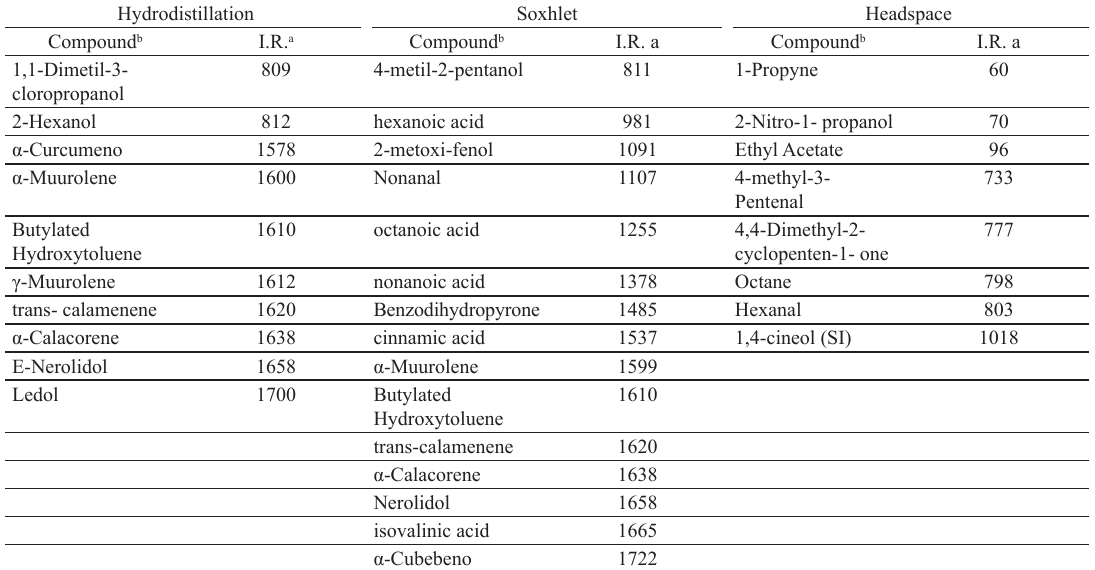
Table 10. Compounds detected in Amburana cearensis essential oils extracted by hydrodistillation, soxhlet and headspace. Hydrodistillation Soxhlet Headspace